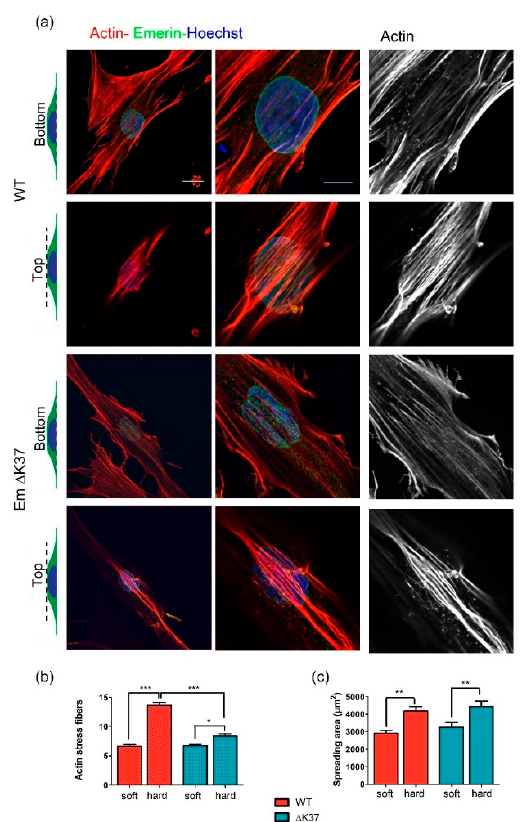
Figure 5. Mutation ∆ K37 impairs perinuclear actin organization on cells grown on a hard substrate. ( a ) Representative images of wild-type (upper panel) and ∆ K37 (lower panel) myofibroblasts, plated on 2D hard substrate stained for F-actin (phalloidin, red), emerin (green) and nuclei (Hoescht, blue). Sections of actin filament network are shown at basal and apical surfaces of the cell, as indicated on the left. Scale bar, 20 µ m, or 10 µ m (zoom). ( b ) Quantification of perinuclear actin stress fibers in wild-type (red) and ∆ K37 (blue) myofibroblasts on soft (8 kPa) and hard (glass) substrates. Data represent mean ± SEM. Mean number from n = 30 ± 1 cell for each group from two independent experiments. * p < 0.05, *** p < 0.01. n = 0.001. ( c ) Quantification of wild-type (red) and ∆ K37 (blue) myofibroblasts spreading areas on soft (8 kPa) and hard (glass) substrates. Data represent mean ± SEM. ** p < 0.01. n > 33 cells for each group from two independent experiments.